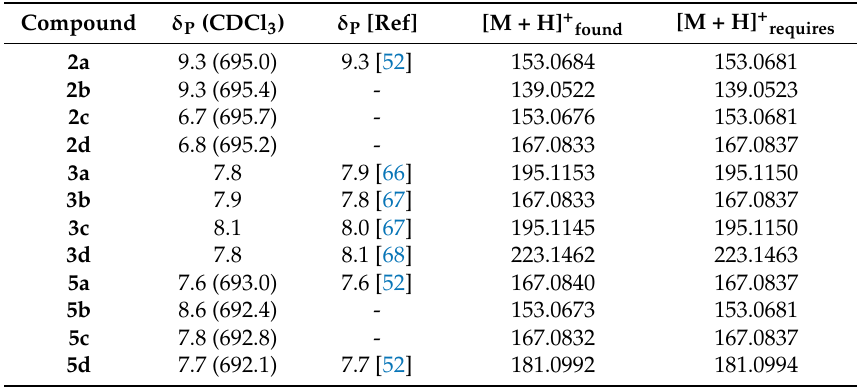
Table 7. 31 P-NMR and mass data for the dialkyl H -phosphonates